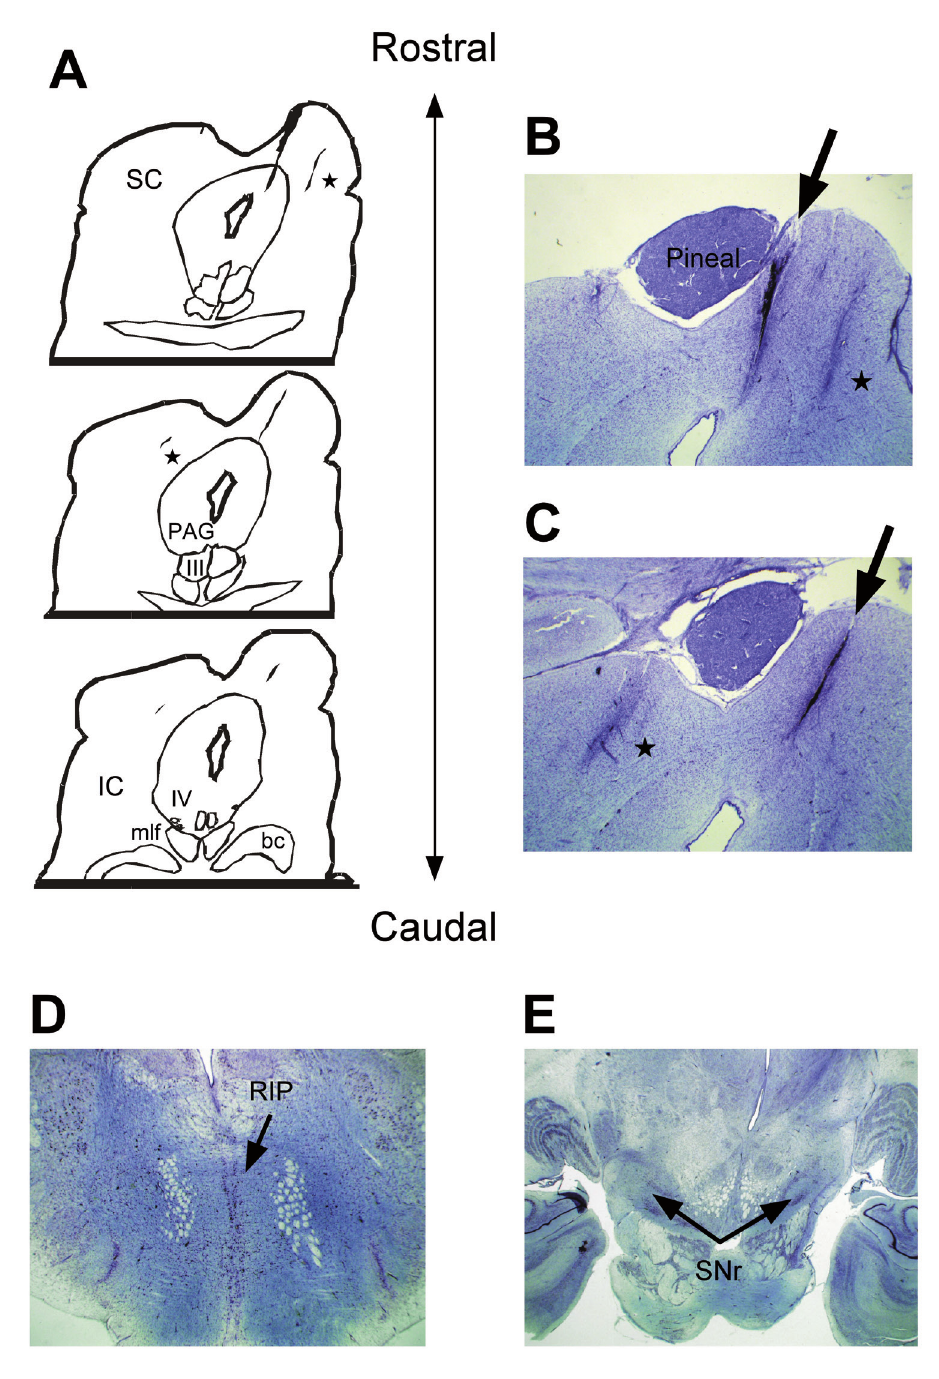
Figure 2. Anatomy of the rostral superior colliculus. Panel A shows tracings of the superior colliculus (SC) and other structures in the brainstem relative to the lesion we found bisecting the commissure and the right rostral medial SC. Panels B & C show photomicrographs taken of the lesion as indicated by arrows. Two other electrode tracts are indicated by asterisks. Panels D & E show that the RIP and the SNr, respectively, of this monkey remained intact and undisturbed. Abbrevations: SC) superior colliculus, IC) inferior colliculus, PAG) periaqueductal gray, III) oculomotor nerve, IV) trochlear nerve, bc) brachium conjunctivum, RIP) raphe interpositus, SNr) substantia nigra